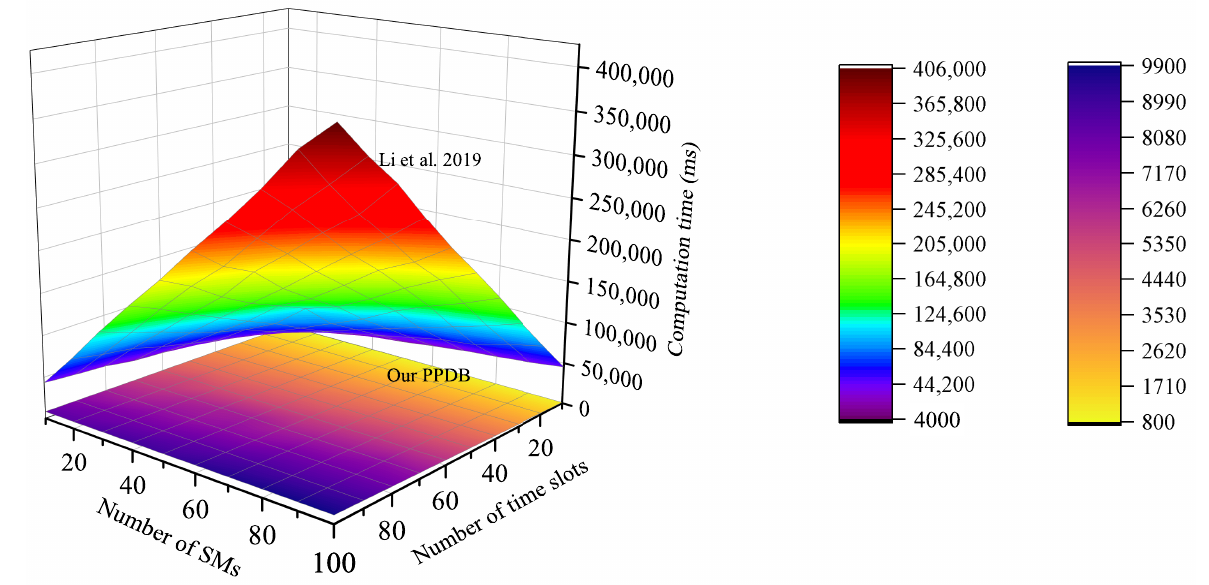
Figure 8. Comparison of computation time between Li et al. [23] and our PPDB in Billing